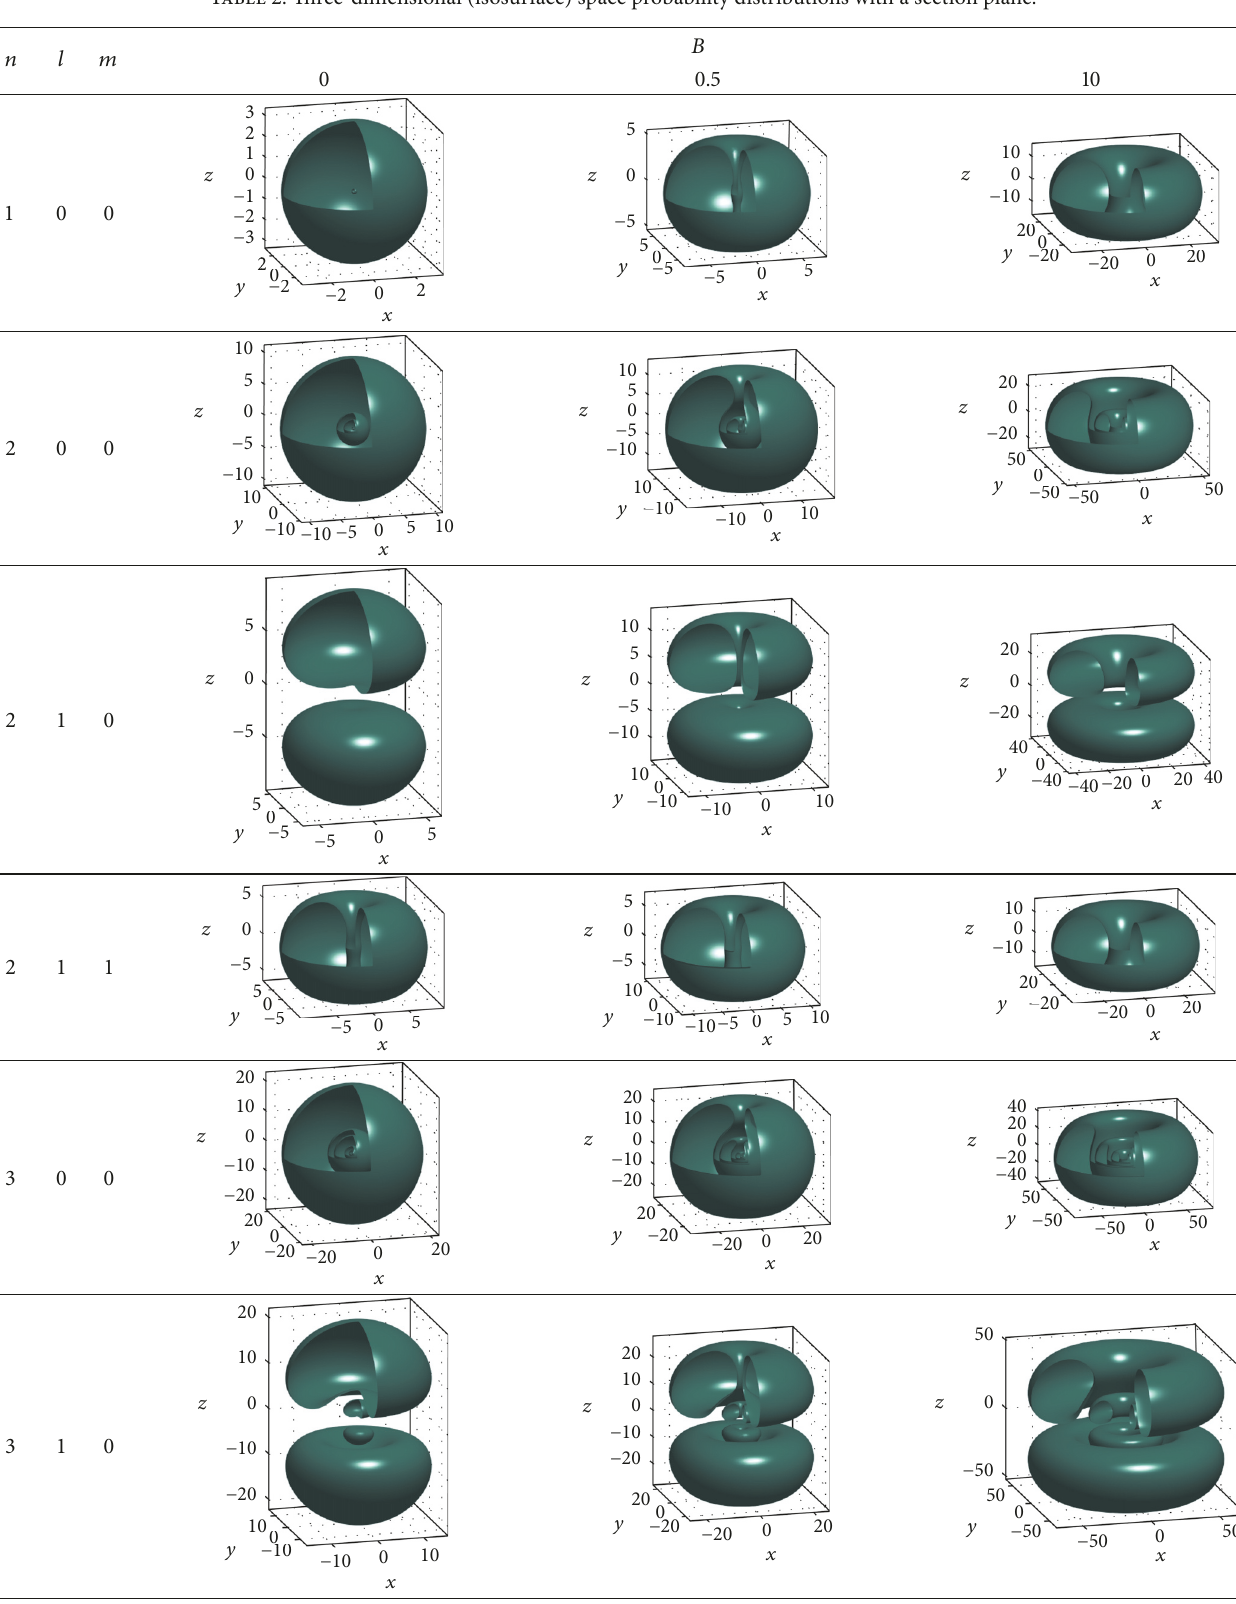
Table 2: Three-dimensional (isosurface) space probability distributions with a section